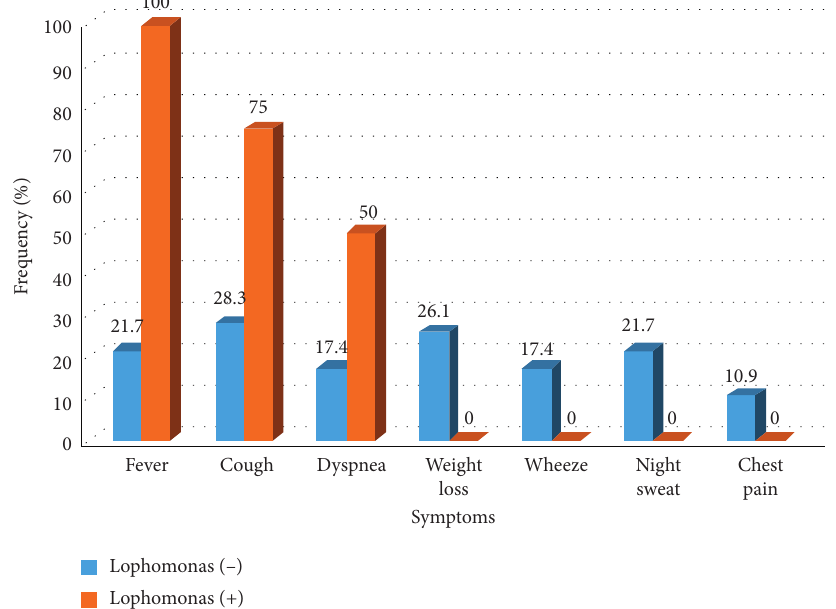
Figure 2: Comparison of clinical signs among patients of the case group with lophomoniasis and without 142 BAL samples of kidney transplant recipients by Wang